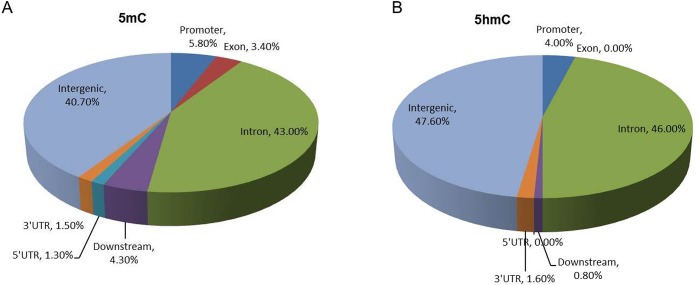
Genomic distributions of DMR (A) and DHMR (B) between case and control groups.The genomic features (extrons, introns, and intergenic regions) were defined based on RefSeq gene (hg19) annotations. The promoter was defined as -2 kb to +2 kb relative to TSS. UTR: Untranslated Regions.